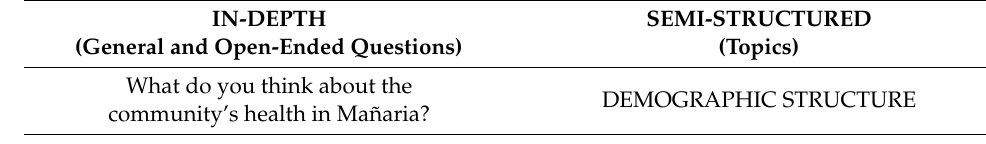
Table 2. Interview guide for in-depth and structured interviews.